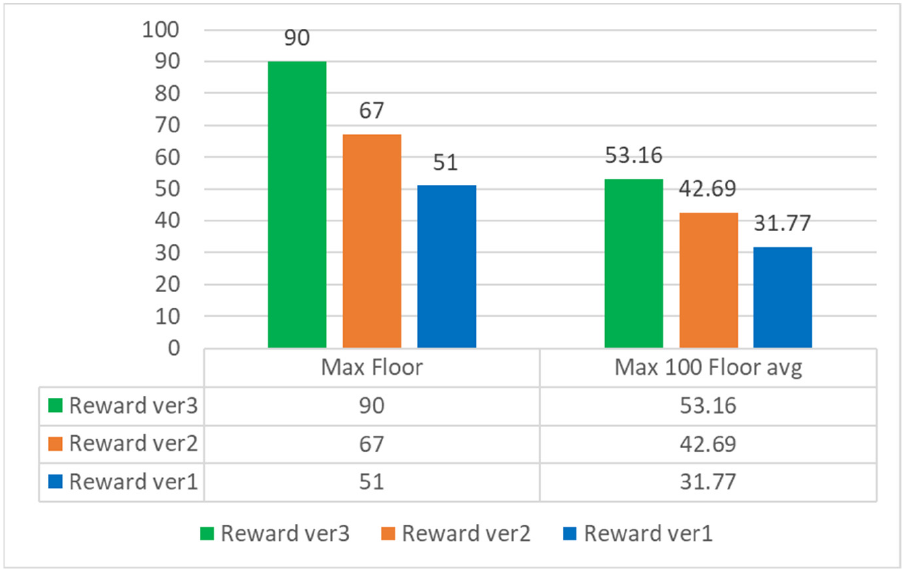
Figure 19. 400 round statistics.